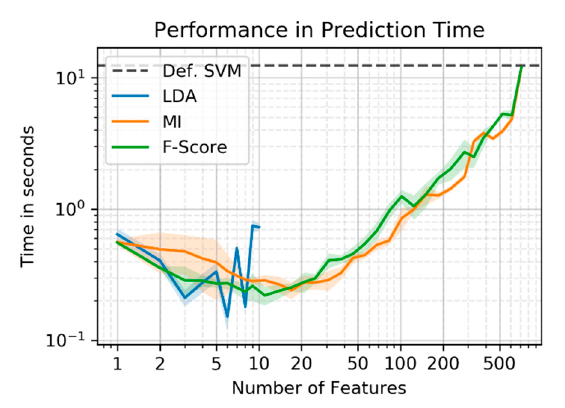
Figure 8. Prediction times as function of the number of features used for different methods (Stockholm).